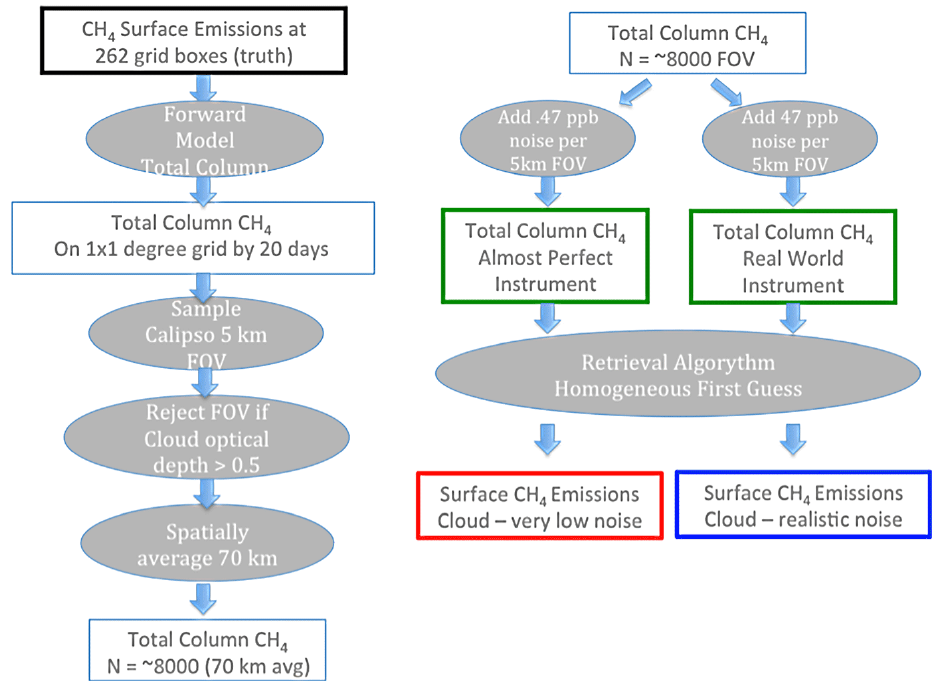
Fig. 7. Our approach to test the sensitivity of a proposed laser CH 4 instrument to changes in surface emissions. First we produce values of simulated column CH 4 observed by a laser instrument (green boxes) from gridded CH 4 surface emissions (black box). We include the effect of a proposed satellite platform orbit, field-of-view instrument sampling, rejection of data for cloudy conditions, and instrument noise. Finally, we retrieve surface emissions (red and blue boxes) from the simulated column CH 4 observations. Gridded arrays of the starting (true) and retrieved surface emissions are shown in Fig. 9. See text for further